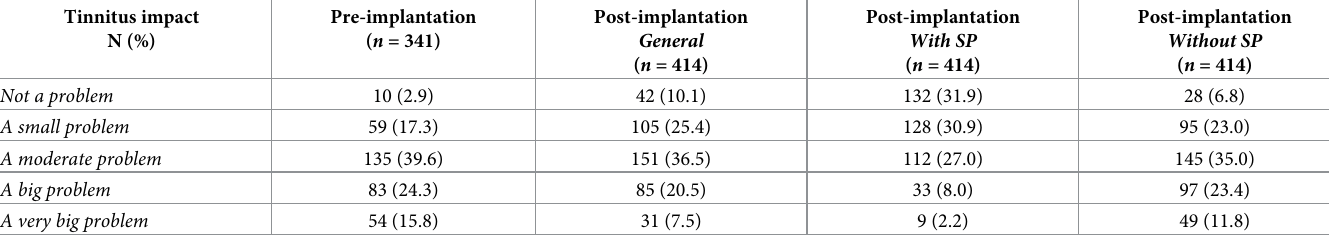
Table 3. Tinnitus